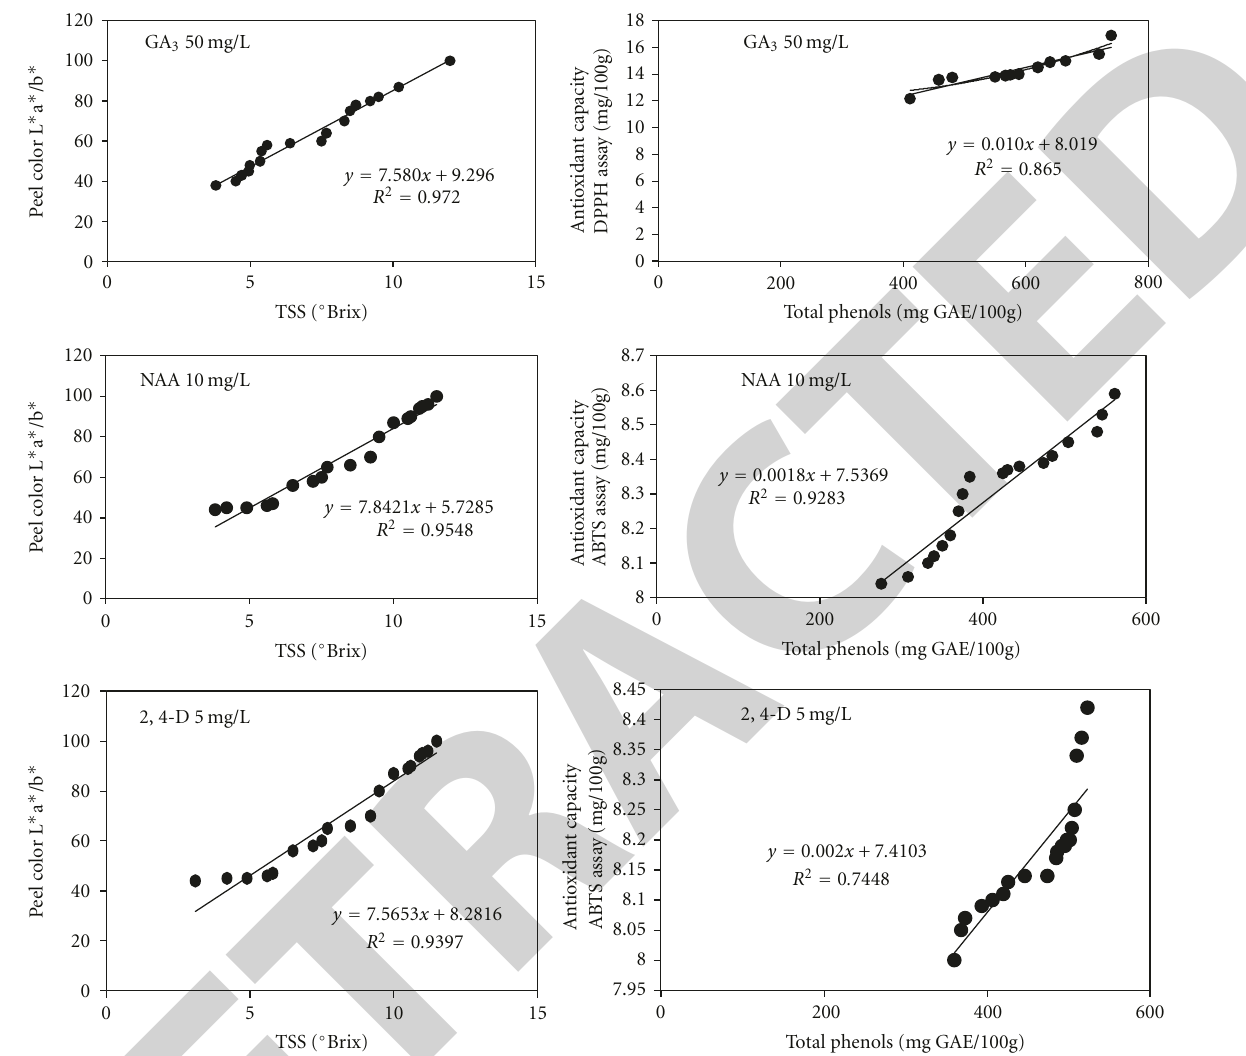
Figure 3: Correlation between peel colour and TSS and total phenols and antioxidant capacity in the GA 3 , NAA, and 2,4-D treated fruits.